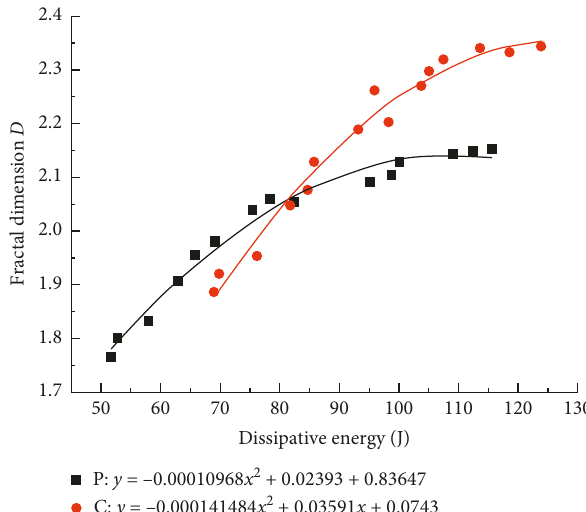
Figure 13: Relationships between the fractal dimension of parallel- and vertical-bedding samples and rupture dissipation